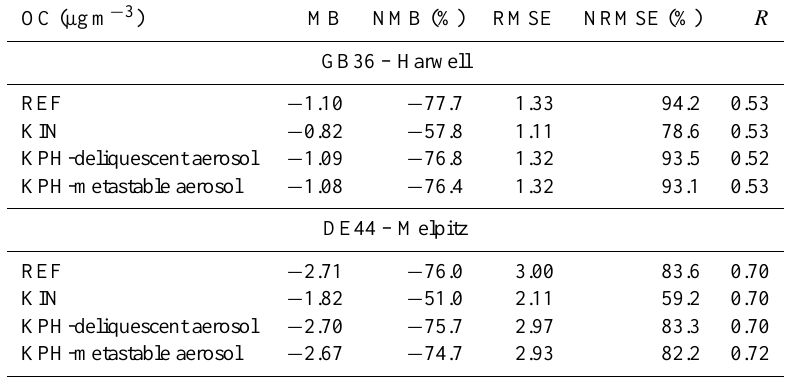
Table 2. Statistical results for organic carbon (OC) simulation (reference, KIN approach, KPH deliquescent and metastable